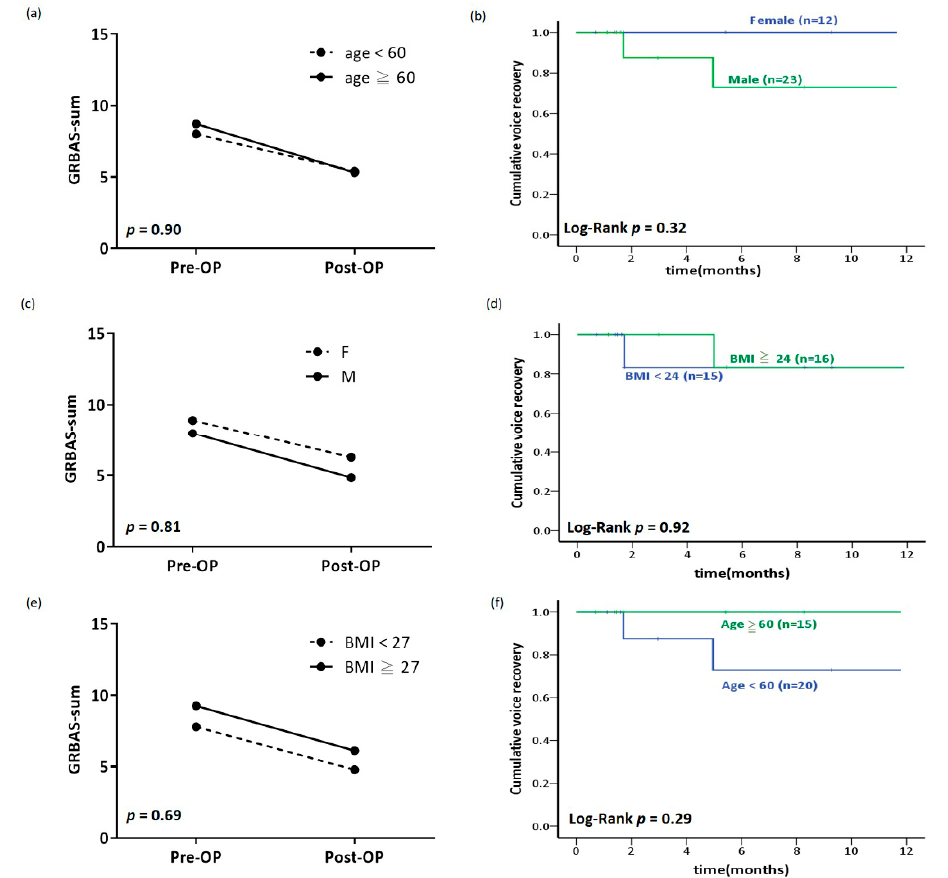
Figure 3. The change in grade, roughness, breathiness, asthenia, and strain-sum percentage by ( a ) age, ( c ) sex, and ( e ) body mass index before and after Medialization laryngoplasty with autologous thyroid cartilage (MLATC). The Kaplan-Meier plot of cumulative voice recovery of ( b ) age, ( d ) sex, and ( f ) body mass index after MLATC.